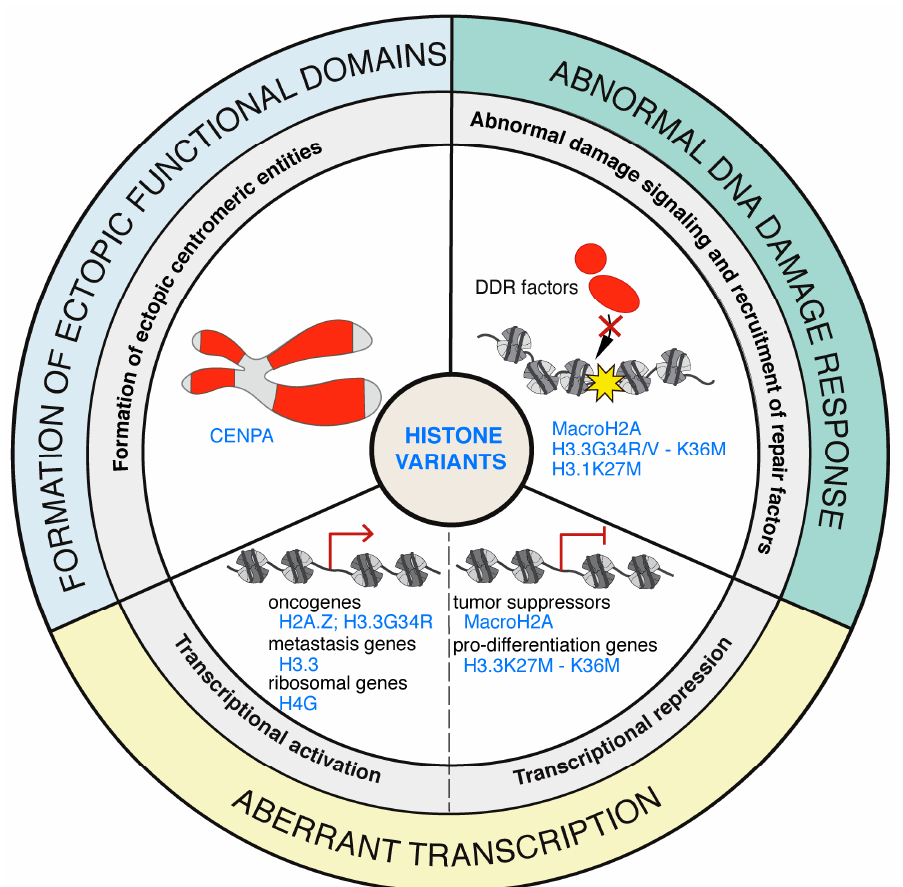
Figure 5. Hallmarks of histone variant dysregulation in cancer. Cellular processes affected by histone variant dysregulation in cancer (highlighted in red) with examples of the associated altered histone variants. DDR: DNA damage response.